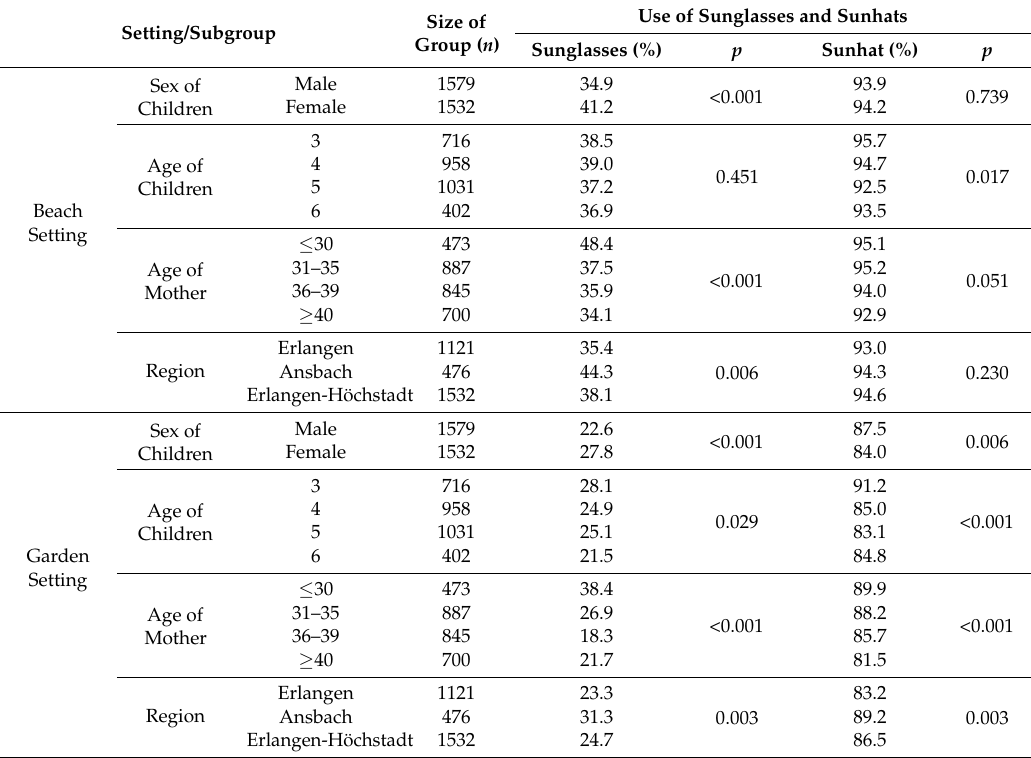
Table 3. Relative frequencies of wearing sunglasses and sunhats in two outdoor settings (beach—upper part and garden—lower part) based on answers of 3129 parents of three- to six-year old children in the Erlking-II-study in three Bavarian districts in Southern